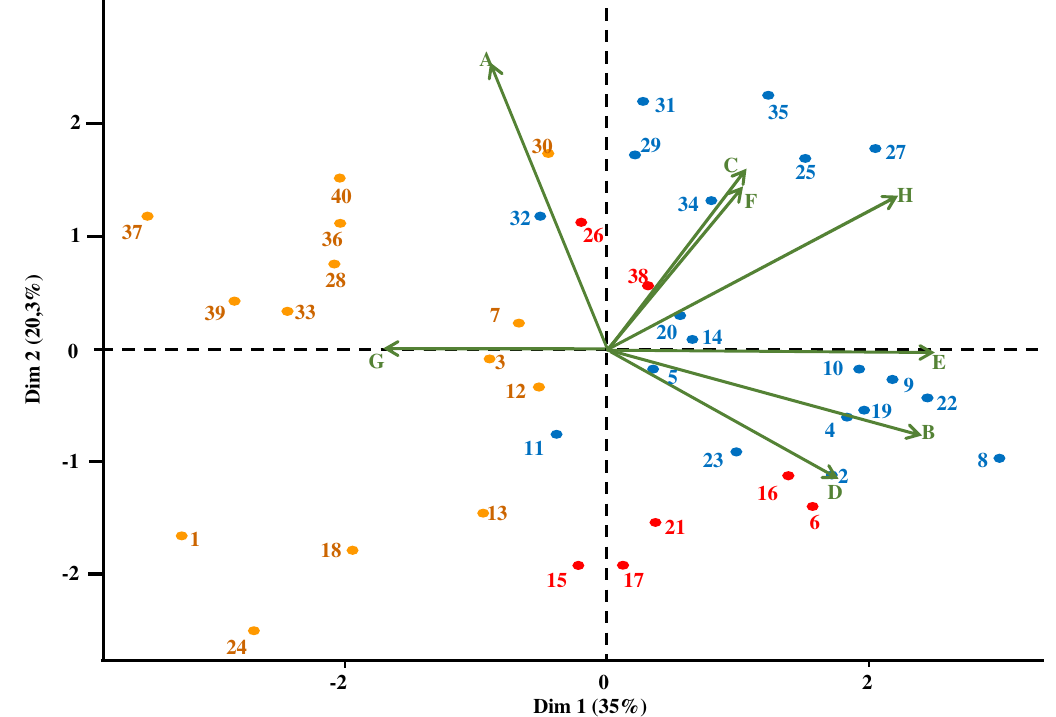
Figure 1. Principal component analysis biplot. Participants with DS are represented from 1 to 24 for men and 25 to 40 for women. Each point represents a subject and the color its membership in the cluster. On this graph, two diametrically opposed vectors are negatively correlated, two vectors forming an acute angle are positively correlated, two vectors forming a 90° angle are independent of each other. The greater the distance between the vectors, the closer their relationship is to the significant threshold. A subject near a vector reveals a high score for this variable, a subject diametrically opposed to a vector reveals a low score for this value. A: gender, B: VO 2peak , C: Flexibility, D: isometric strength, E: explosive strength, F: dynamic balance, G: BMI, H: static balance factor.